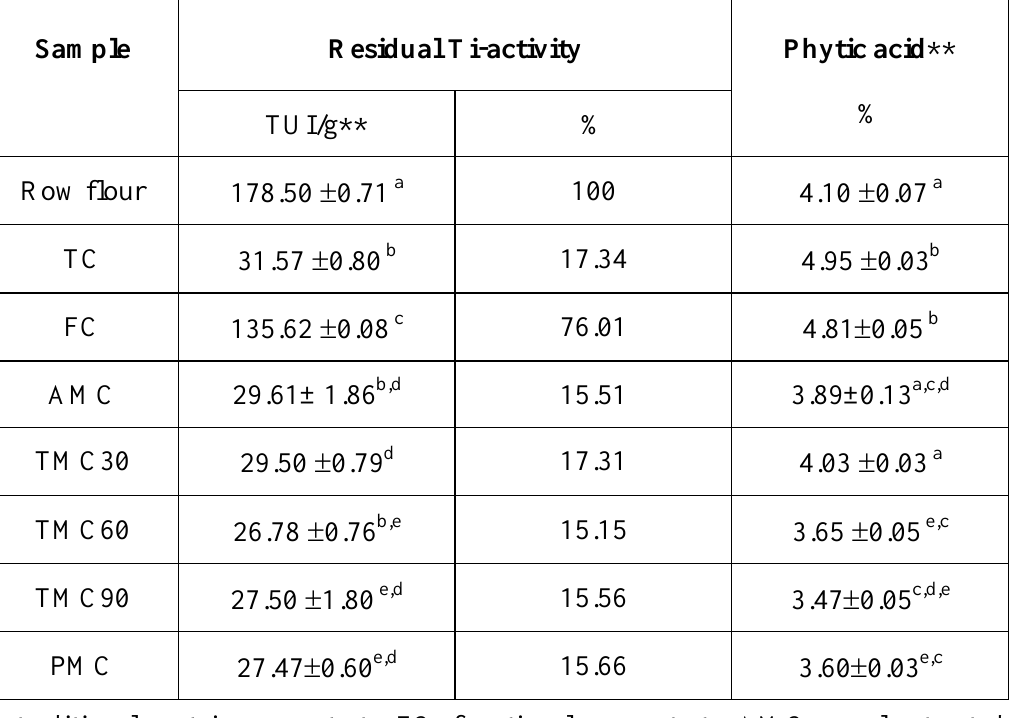
Table 3. Trypsin inhibitor activity and phytic acid content of traditional and modified